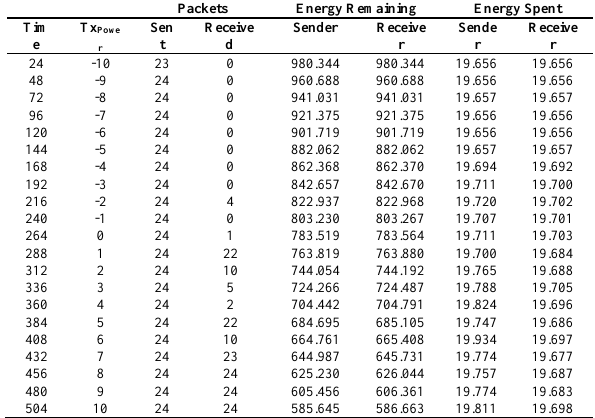
Table 9. Packets and Remaining Energy ( Scenario 1b ).